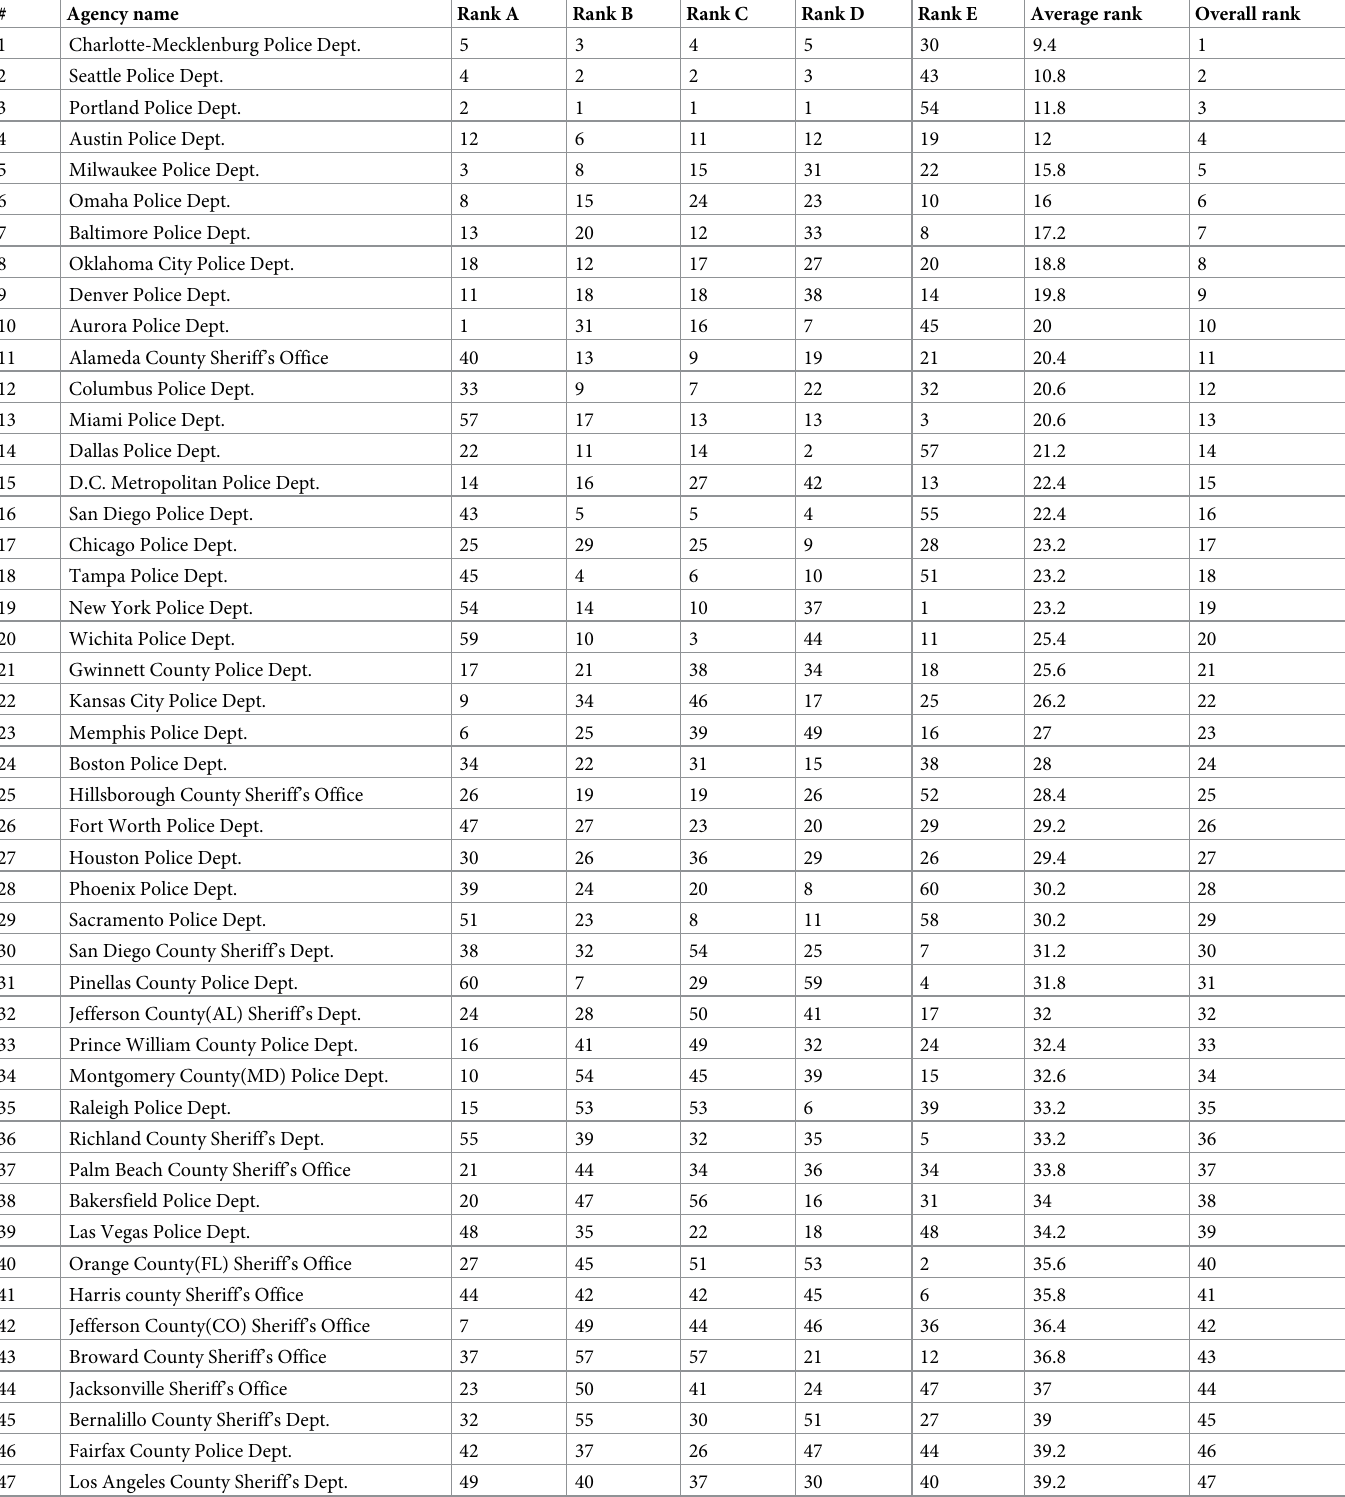
Table 13. Agencies (in the higher-use group) ranked by the five dimensions